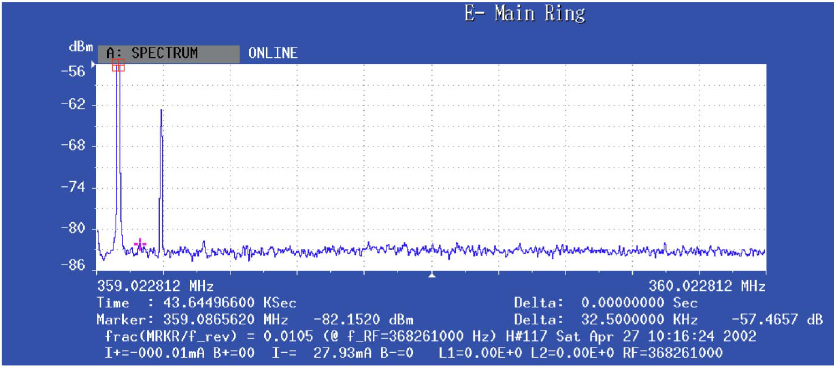
FIG. 15. (Color) Electron single bunch frequency power spectrum shows q -pole excitation at 26 mA.